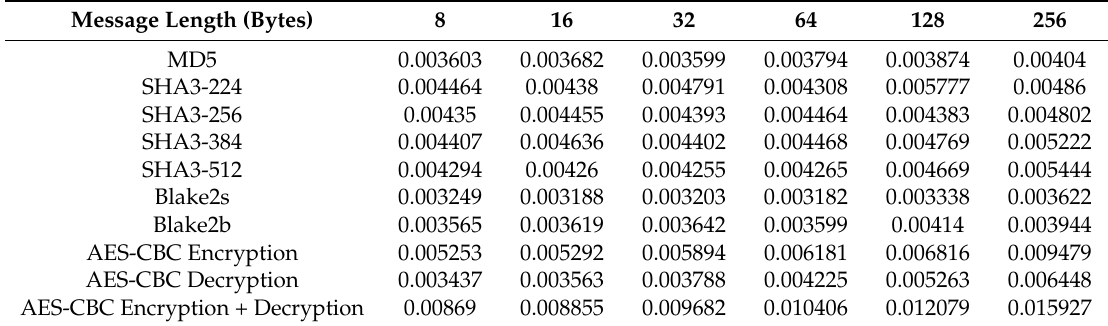
Table 1. Timing sample for HMAC generation and symmetric key encryption with different message